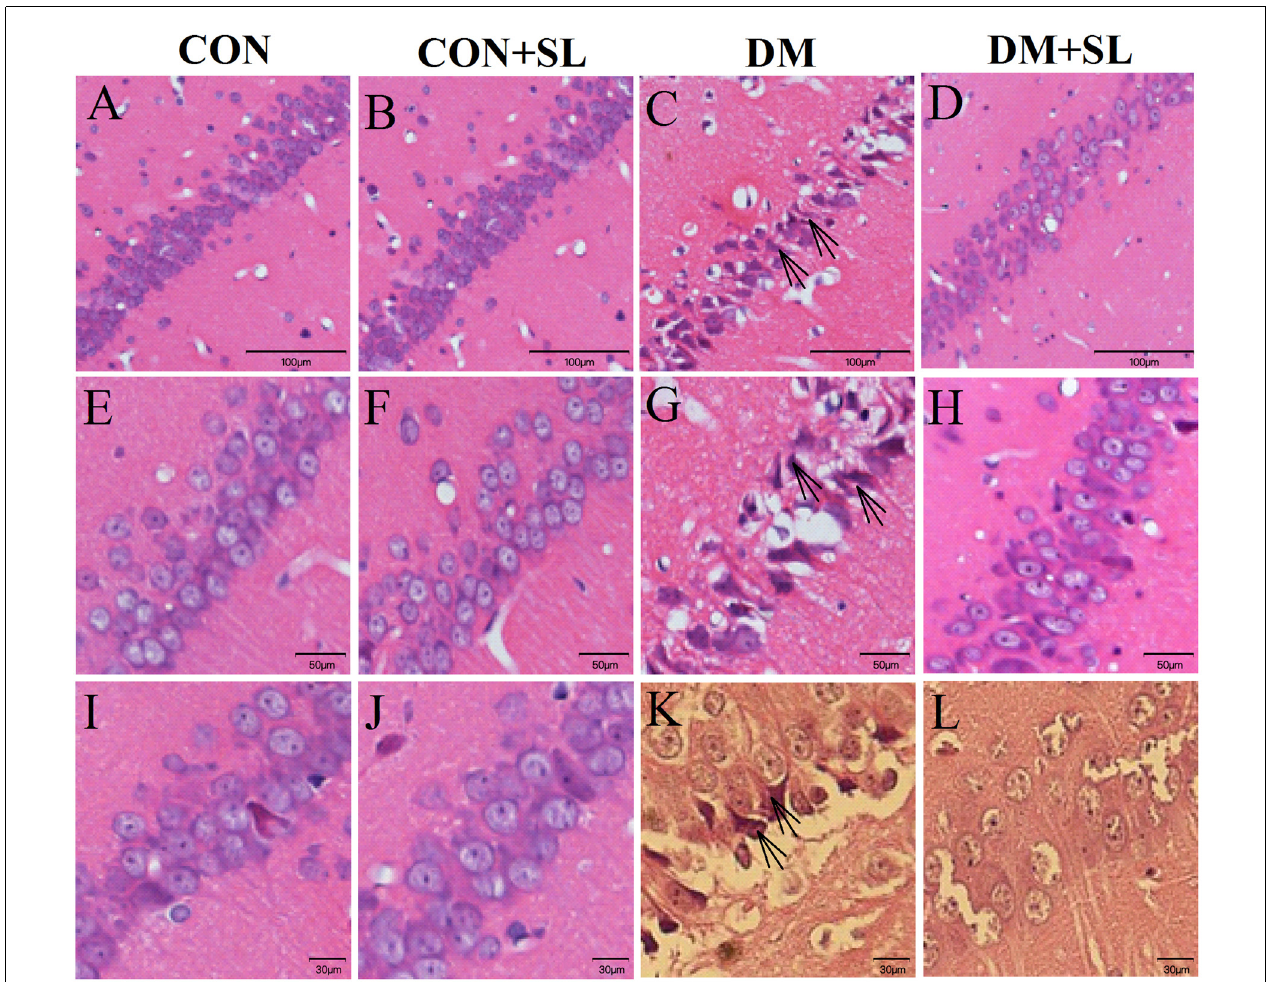
FIGURE 3 | Morphological changes in the neurons in the CA1 hippocampal region of diabetic rats were observed under an optical microscope. Representative images of HE staining in brain slices of the hippocampus. (A–D) Magnification 4 × , (E–H) Magnification 10 × , (I–L) Magnification 40 × . The arrow points to a positive sign (disorder arrangement, dilated intercellular spaces and karyopyknosis) n =